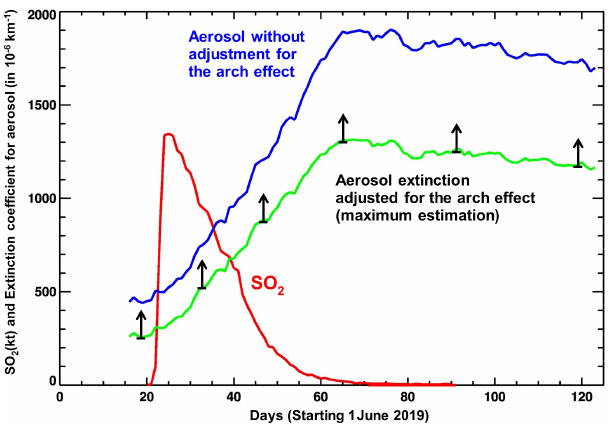
Figure 6. The daily zonal mean (45–85 ◦ N) SO 2 mass (assuming a cloud height of 13km) and the average aerosol extinction coeffi- cient at 675nm (summed up over 13–18km and divided by 6 (km) to get the average extinction coefficient). The arrow bar shows the maximum possible error in calculating the aerosol extinction due to the arch